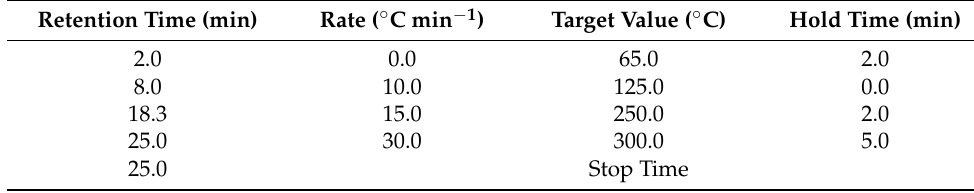
Table 9. Gas chromatography oven temperature program.